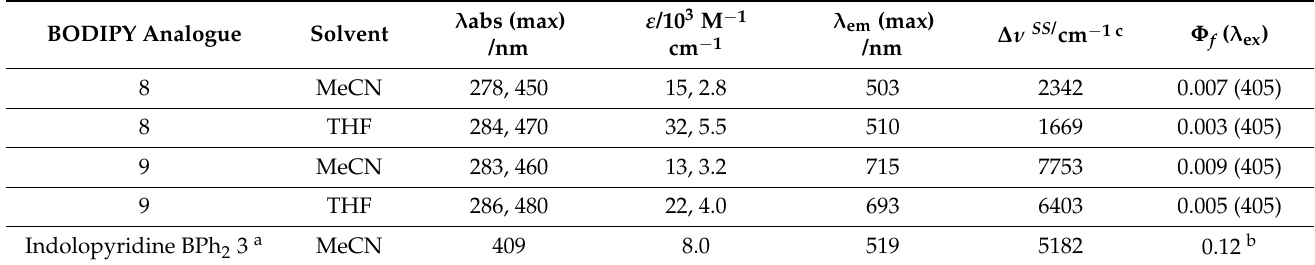
Table 1. Photophysical data for the selected BODIPY